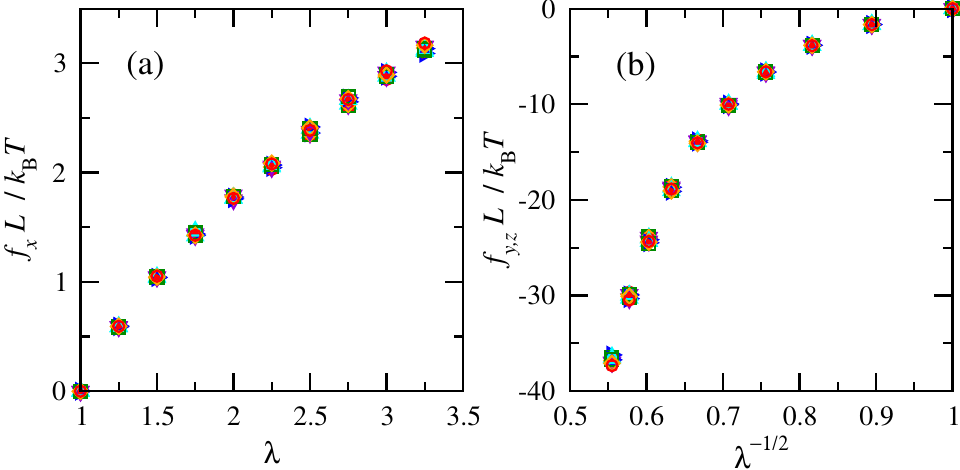
Figure 6. Normalized ( a ) tension and ( b ) compression forces vs. deformation ratio for cis- and trans- 1,4-polybutadiene RIS chains of 50 repeat units. Filled symbols for cis and open for trans. T = 275 K ( (cid:79) violet); 300 K ( (cid:46) blue); 323 K ( (cid:47) cyan); 343 K ( (cid:77) green); 375 K ( (cid:5) orange); 400 K ( ◦